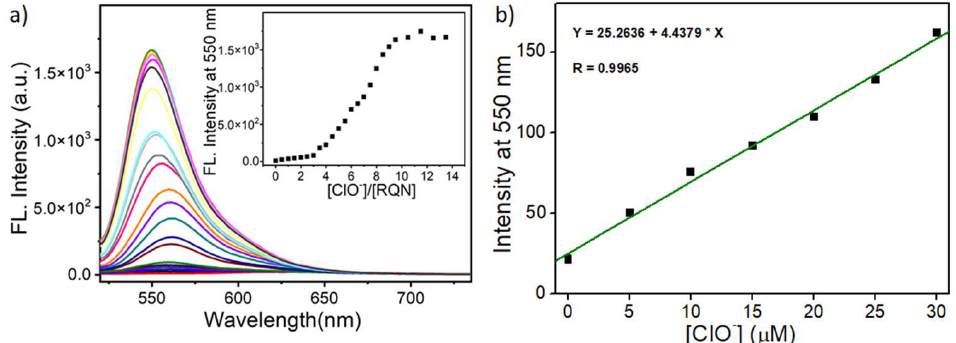
Figure 3. ( a ) Emission spectra response of RHN (10 μM; 10 mM, pH = 7.4, PBS) upon addition of different concentrations of ClO − (0 – 140 μM); Inset: The plot of I 550 versus the equivalents of ClO − ; ( b ) The plot of I 550 versus the concentrations of ClO − (0–30 μM). The conditions: PBS buffer (10 mM, pH = 7.4); λ ex = 500 nm; slits: 10/5 nm. The emission spectra were collected 10 min after the addition of ClO − .